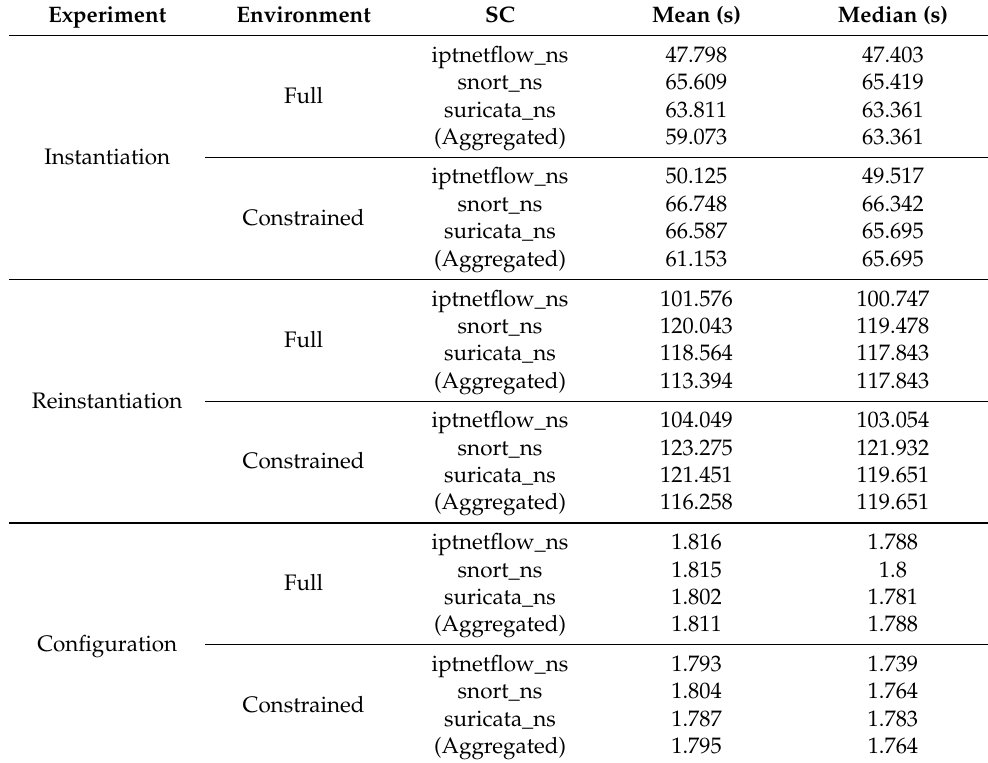
Table 5. Summary of detailed statistic values per experiment, environment, and